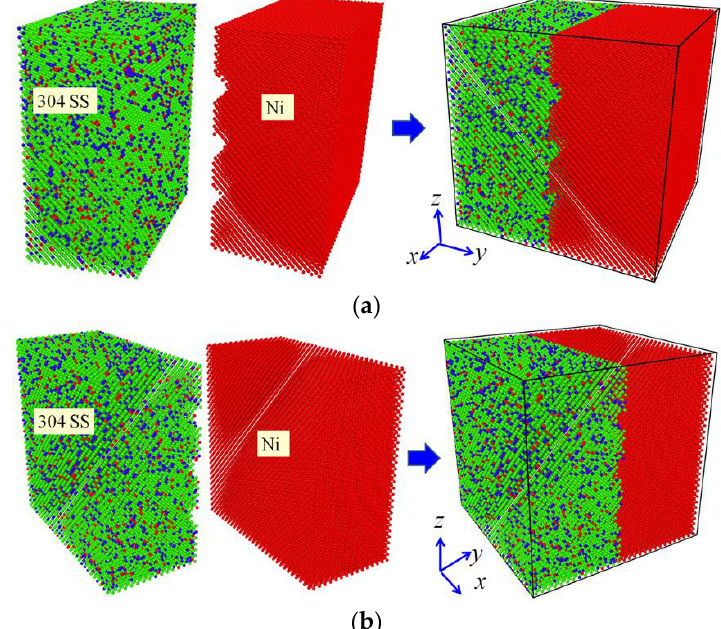
Figure 1. Molecular dynamics (MD) simulation models for the diffusion welding: ( a ) Model Ι; ( b ) Model ΙΙ. (In the models, Fe atoms are presented by green color, Ni atoms are denoted by red color and Cr atoms are exhibited by blue color).